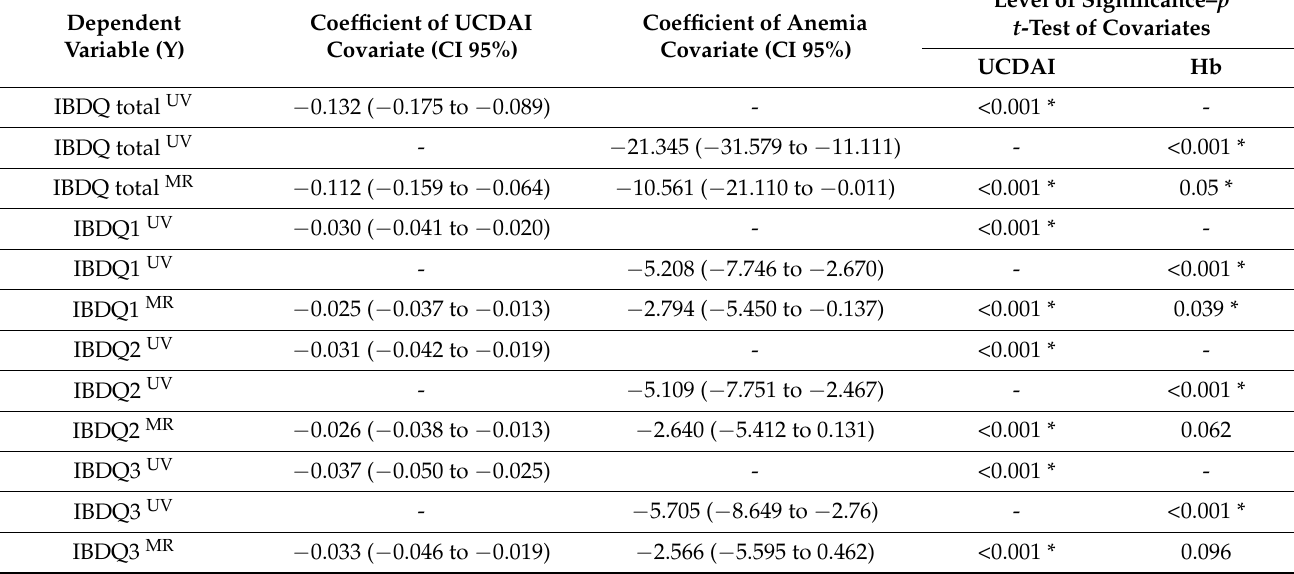
Table 6. Effect on quality of life scores by univariate and multiple